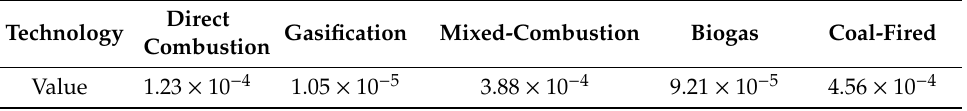
Table 7. Total environmental